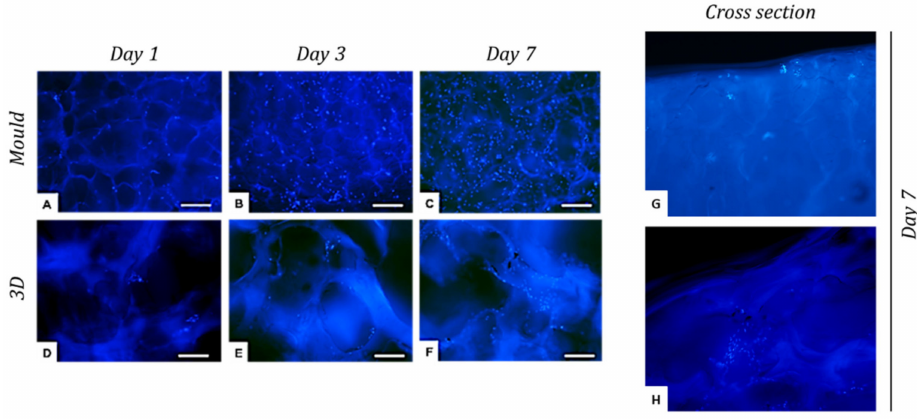
Figure 11. Scaffold colonization analysis by nuclei detection with DAPI in 3D-printed and mould- casted scaffolds at day 1 ( A , D ), day 3 ( B , E ), and day 7 ( C , F ). A cross section image was taken of both the scaffolds to highlight the inner spreading of the cells, respectively, within the mould-casted ( G ) and 3D-printed ( H ) scaffolds. Scale bars: ( A – F ) 200 µ m; ( G , H ) 500 µ